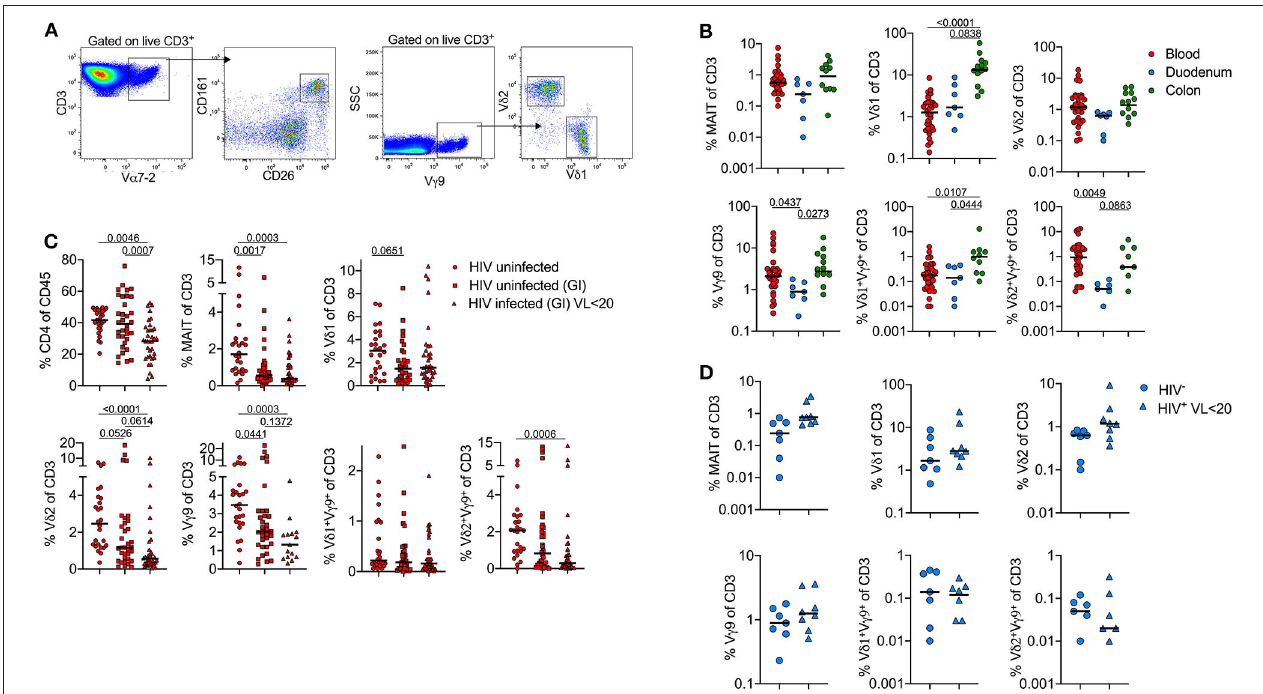
FIGURE 2 | Frequency of unconventional T-cells is associated with concomitant diseases in peripheral blood and tissue-specific compartmentalization. Flow cytometry staining was performed on 75 participants ( Table 1 and Supplementary Table 1 ), each dot represents an individual. (A) Gating strategy to identify donor-unrestricted T-cells: CD3 + V α 7-2 + CD26 + CD161 + (MAIT cells); CD3 + V γ 9 + V δ 1 + and CD3 + V γ 9 + V δ 2 + T-cells. (B) Frequency (% of CD3 T-cells) of MAIT and γδ T-cells subsets in blood (red; n = 26), duodenum (blue; n = 7) and colon (green; n = 12). Only HIV-negative samples from GI cohort were included. (C) Frequency (% of CD3 T-cells) of MAIT and γδ T-cells subsets in blood; comparison between HIV –ve samples from FRESH cohort (circles; n = 26), HIV –ve (squares; n = 35) and HIV + ve samples (triangles; n = 21) from GI cohort. (D) MAIT and γδ T-cell subset frequencies in duodenum pinches; comparison between HIV –ve samples (circles, n = 7) and HIV + ve (triangles, n = 8) samples from GI cohort. Statistical analyses were performed by ANOVA and Dunn’s multiple comparisons test in (B,C) and Mann-Whitney U test in (D) . Black lines represent